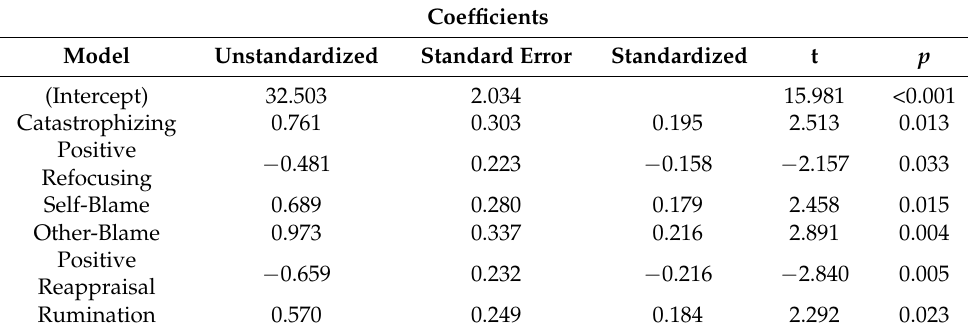
Table 4. Model summary for STAI-T and CERQ